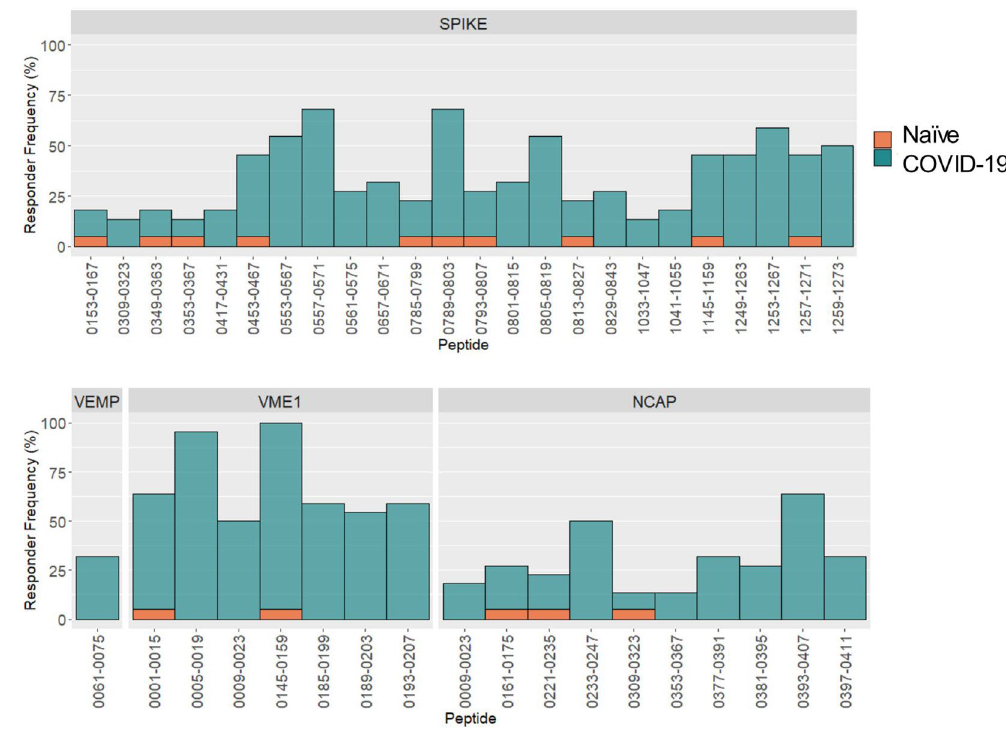
Figure 2. Long-lasting epitope-specific IgG antibodies to SARS-CoV-2 reveal a heterogeneous response with a small subset of shared epitopes. For each differentially reactive peptide ( p -adjusted value < 0.1), the responder frequency was calculated using a cutoff defined as the mean value of the naïve sera samples plus three standard deviations (n = 20), and percent responders among the COVID-19 convalescent sera (n = 22) collected at 5 months post-diagnosis determined. Only peptides with a responder frequency greater than 10% are displayed. NCAP nucleoprotein, VEMP envelope small membrane protein, VME1 membrane